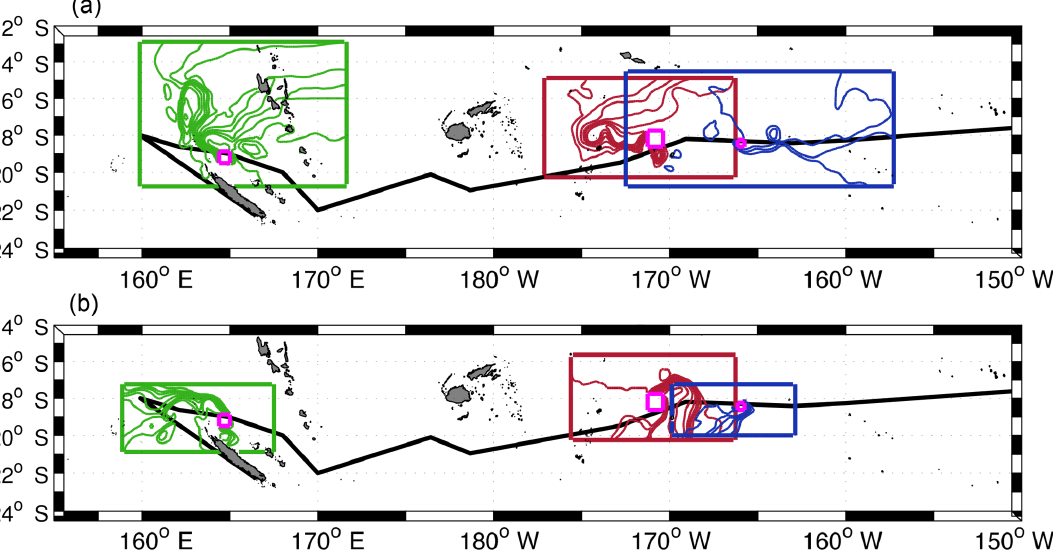
Figure 5. Backward (a) and forward (b) stream functions for LDA (green lines), LDB (red lines) and LDC (blue lines). Numerical particles are initially launched on the magenta boxes which represent the position of each LD station. The domain limit of each Ariane Lagrangian analysis is shown by the large green, red and blue boxes respectively. The ship track of OUTPACE is indicated with the black